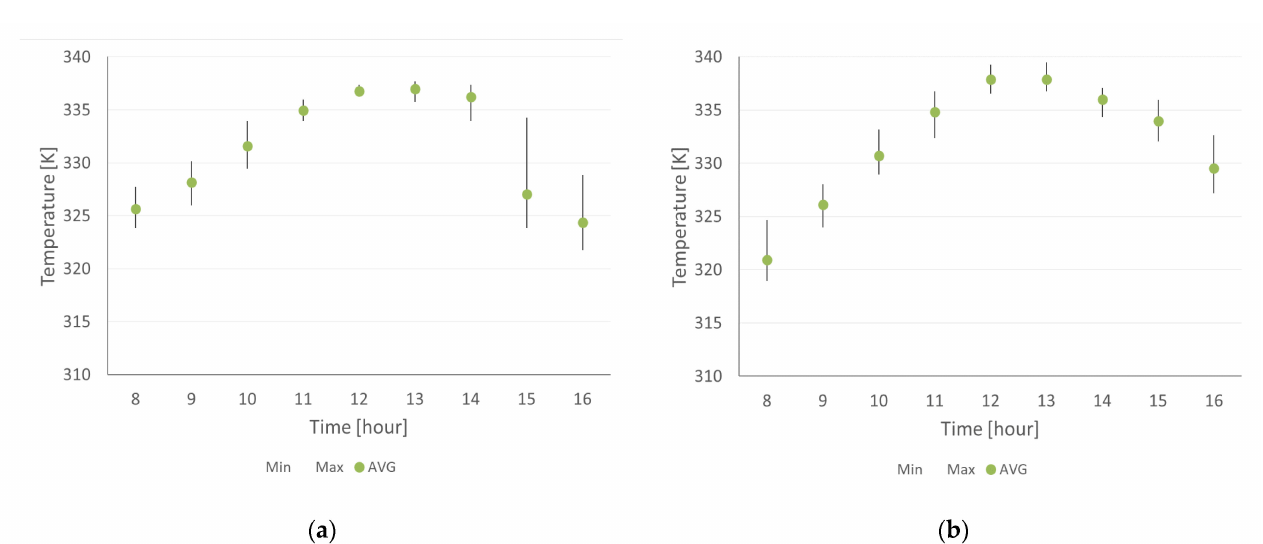
Figure 16. Daily Global Radiation—minimum, maximum, and average hourly intervals for collector with rotation ( a ) 21 March 2019, ( b ) 2 April 2019 and without rotation, ( c ) 29 March 2019, and ( d ) 30 March 2019. (cid:17) (cid:16) (cid:104) t (cid:105) Average hourly output temperature T e ( i = 9, 10, . . . , 16) of the collectors is h , i (cid:17) (cid:16) (cid:104) t (cid:105) at Figure 17. From T e proceeded the minimum temperatures T e , min h , i (cid:17) (cid:16) (cid:104) t (cid:105) the maximum temperatures T e , max . The profile of the minimum temperatures h , i (cid:17) (cid:16) (cid:104) t (cid:105) T e , min is characterized by the effect of changes in the intensity of solar radiation. h , i (cid:17) (cid:16) (cid:104) t (cid:105) The maximum temperatures profile T e , max was corresponding to the theoretical h , i equivalent of the incident radiation.